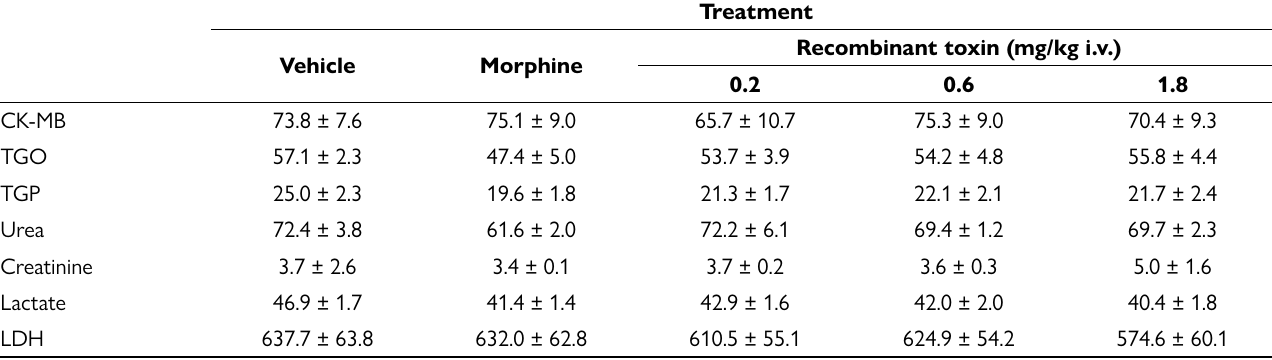
Table 2. Biochemical parameters evaluated in serum samples 24 hours after vehicle, morphine or recombinant Phα1β